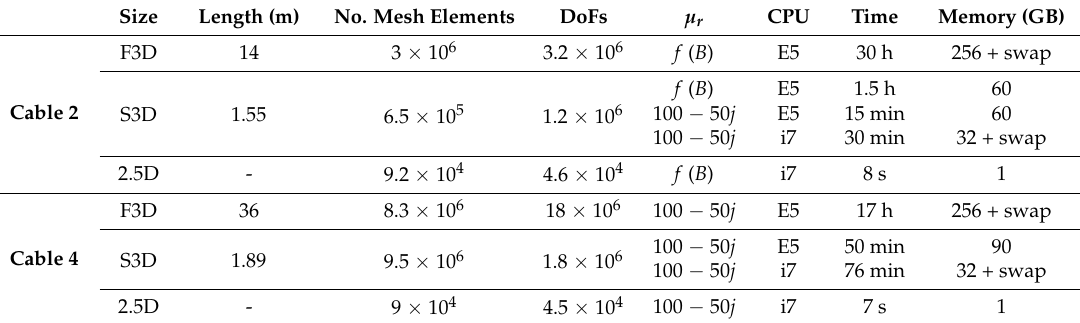
Figure 11. Current density distribution in short periodic model for: ( a ) Cable 2; ( b ) Cable 4. Table 4. Model size and solution time.